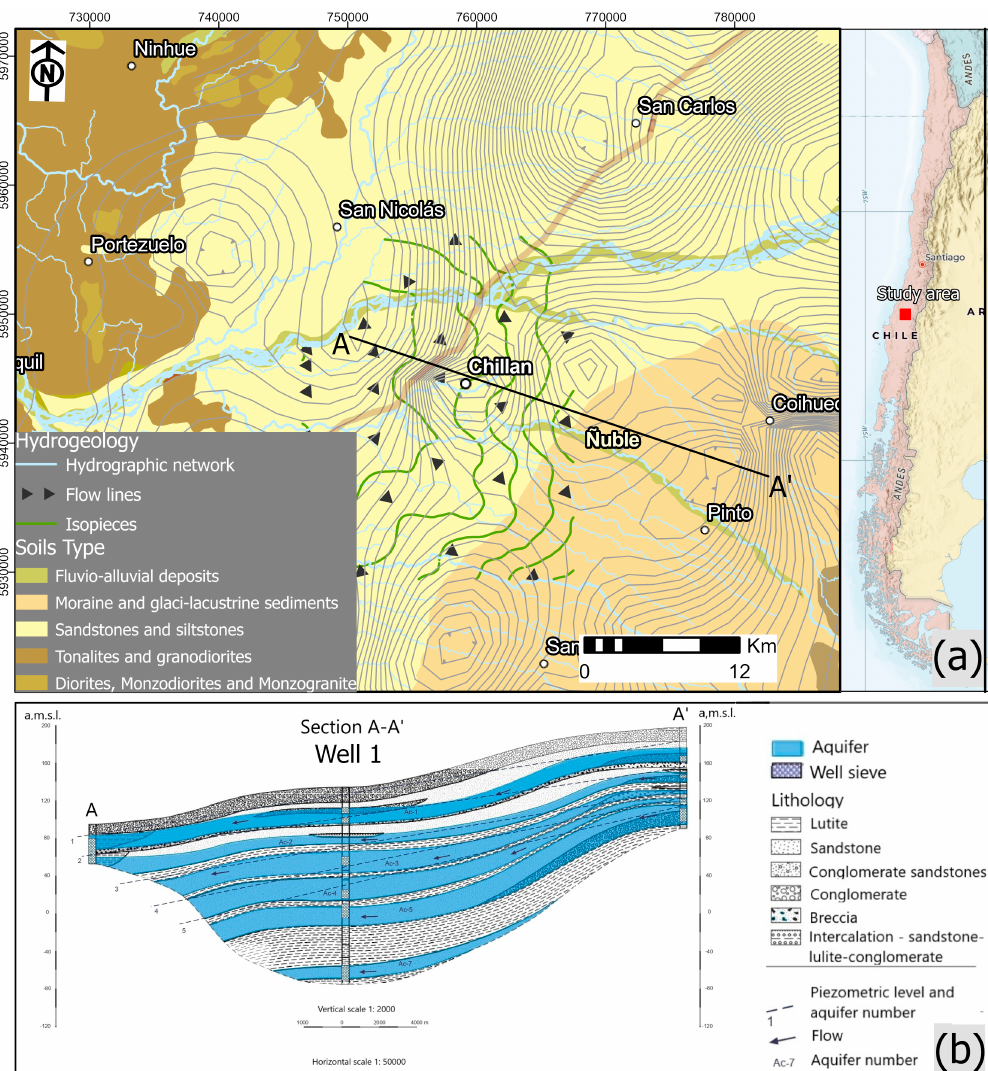
Figure 2. ( a ) Hydrogeological map, and ( b ) Section A-A’ in the study area, (modified from F. Aviles [44]).